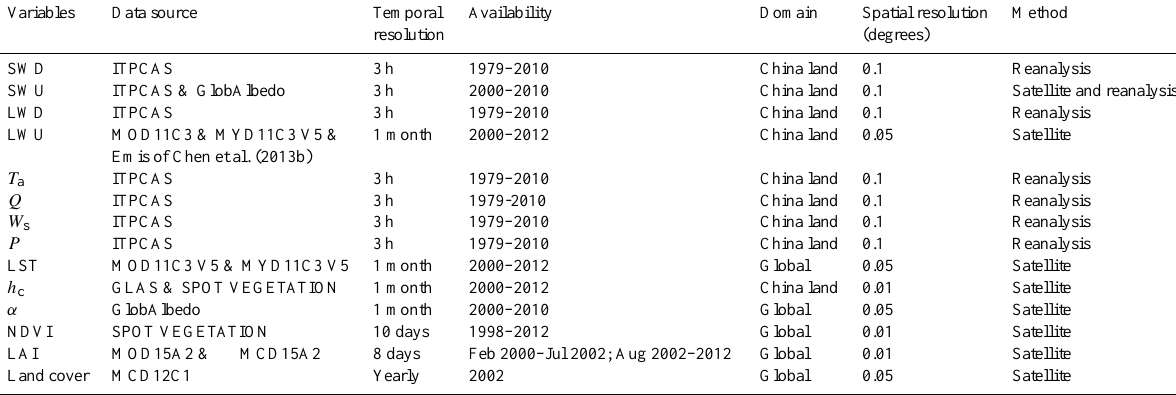
Table 1. Input data sets used for calculating land-surface fluxes for China (see Sects. 2 and 3 for an explanation of abbreviations).